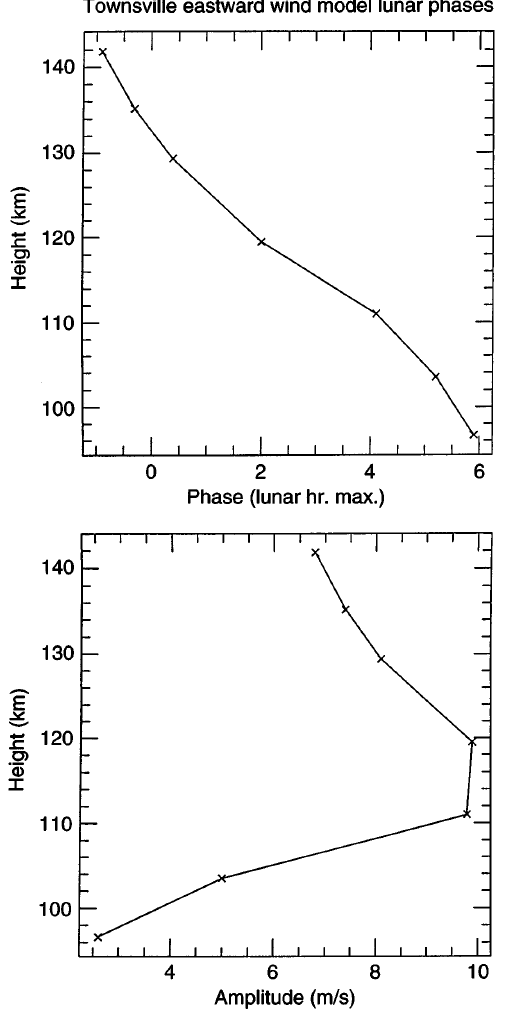
Fig. 9. Variation of phase and amplitude of the lunar tide in the eastward wind as determined by the GSWM at the location of Townsville (22 (cid:176) S)